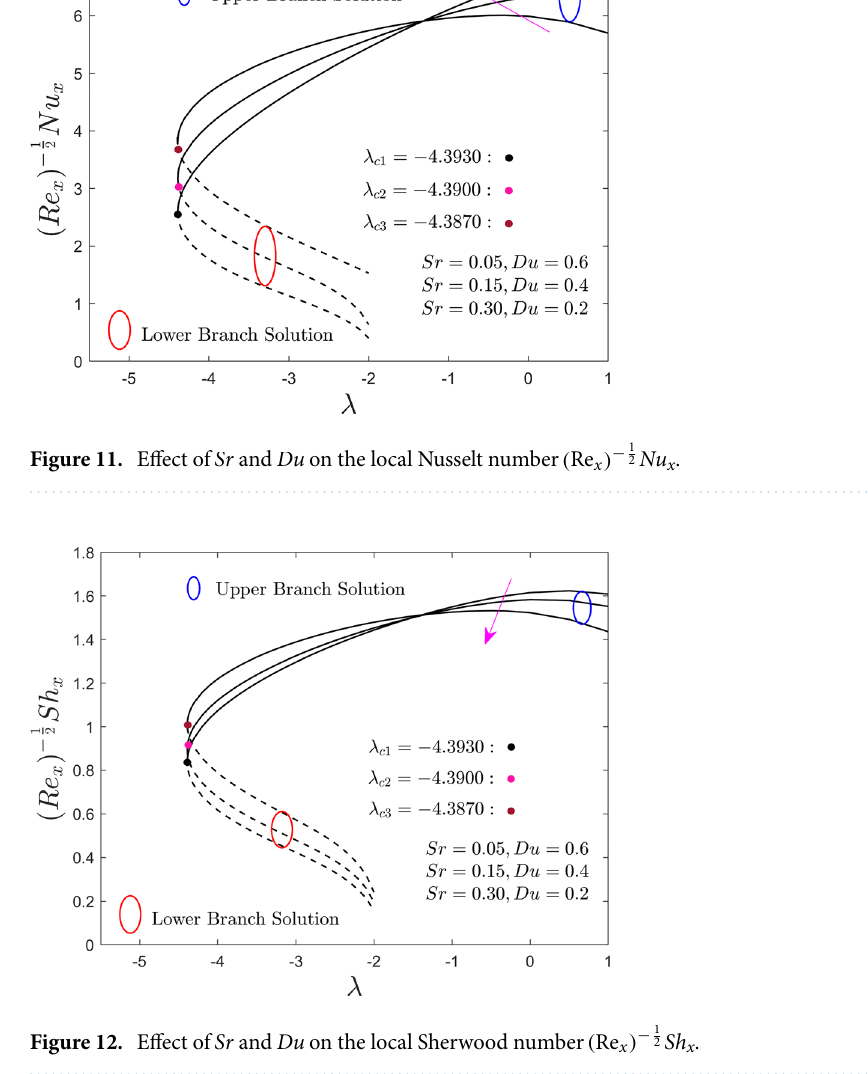
Figure 12. Effect of Sr and Du on the local Sherwood number ( Re x ) −